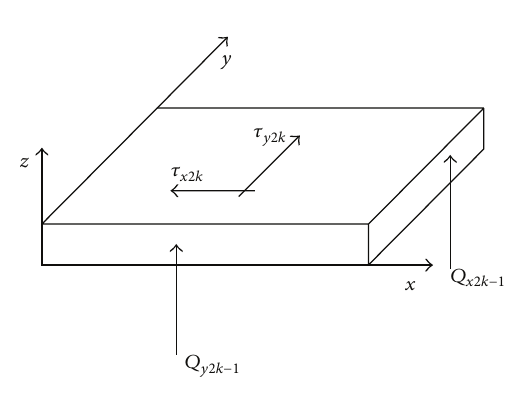
Figure 5: Internal stress of the damping layer.